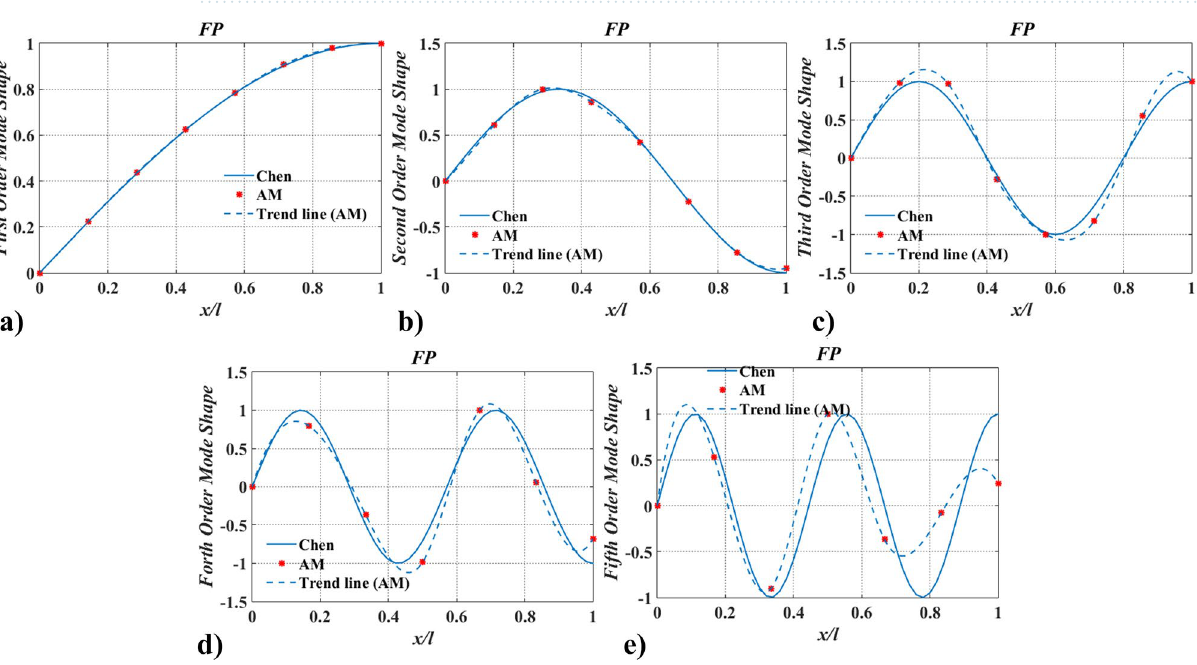
Figure 9. The lowest five mode shapes of twisting angles for the shaft carrying five concentrated elements in the FP support conditions obtained from Chen 20 and AM (small number of discrete